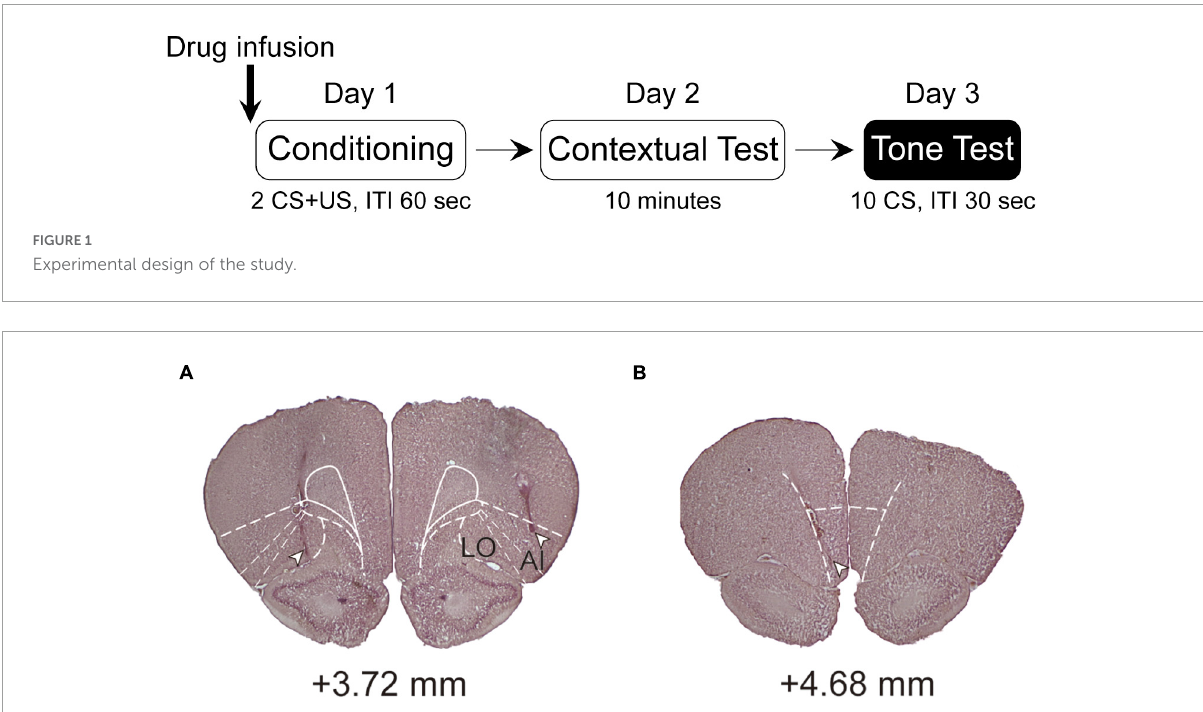
FIGURE2 Histological analyses and conformation. (A) A coronal section showing an example of cannula placement in the lOFC. (B) A coronal section showing an example of cannula placement in the mOFC. Level of +3.72 and +4.68 mm, anterior relative to bregma. LO, lateral orbital area; AI, agranular